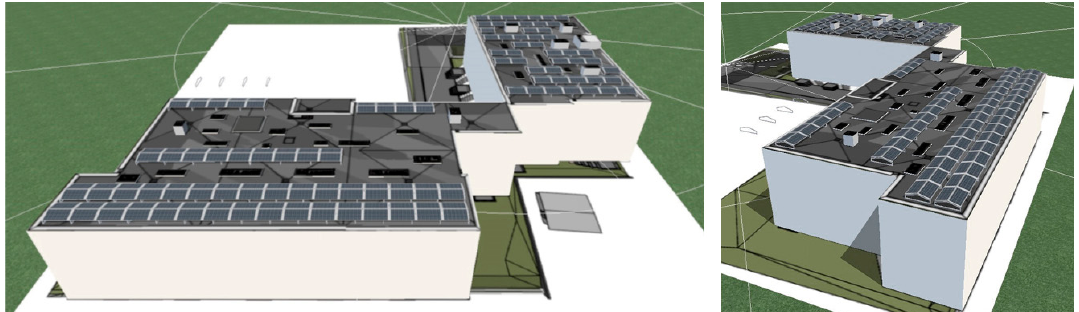
Figure 4. The building at Akacjowa Street in Goleniow, concept of photovoltaic panel arrangement view. Source: Foton OZE sp. z o.o.